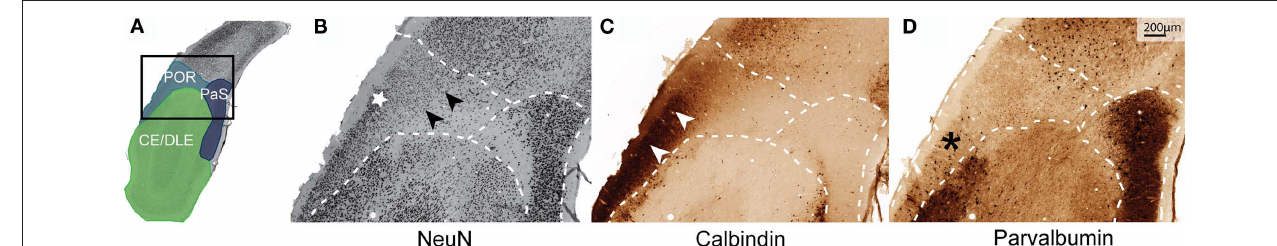
(C , D) Images from positions corresponding to (B) in neighboring sections stained for calbindin (C) and parvalbumin (D) . The postrhinal cortex is characterized by absence of a lamina dissecans (black arrowheads in B ), presence of homogeneously packed, small, and lightly stained neurons in layers II–III, with layer II cells having a somewhat clustered appearance with an irregular border with layer I (white star in B ), presence of calbindin positive cells and neuropil in superficial layers (white arrowheads in C ), and relatively weak staining for parvalbumin (asterisk in D ). Scale bar,